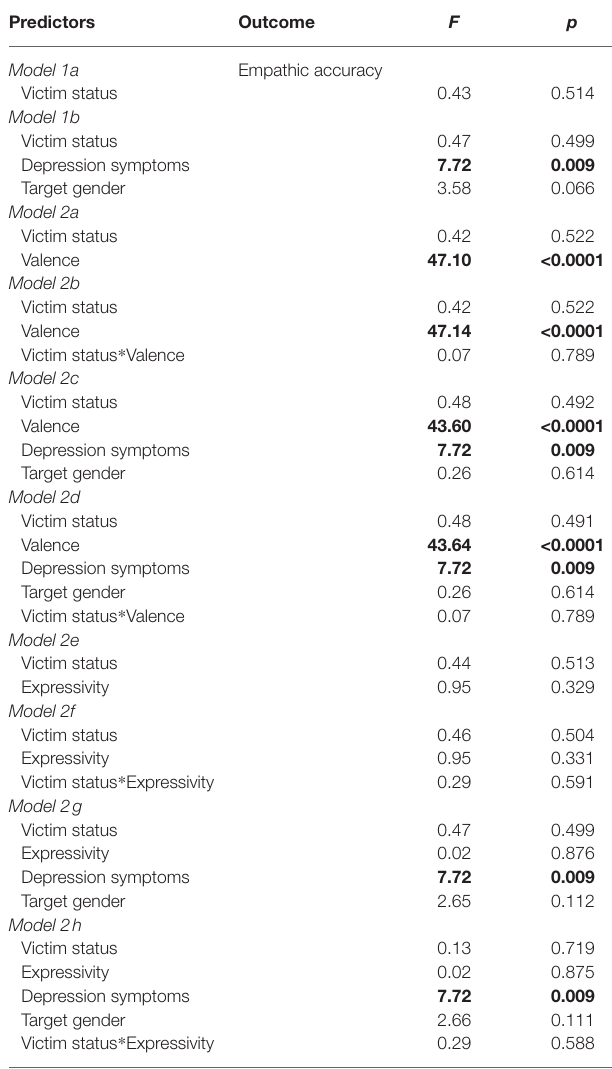
TABLE 4 | Associations between victimization status and empathic accuracy and moderation effects of video clip valence and of targets’ expressivity.